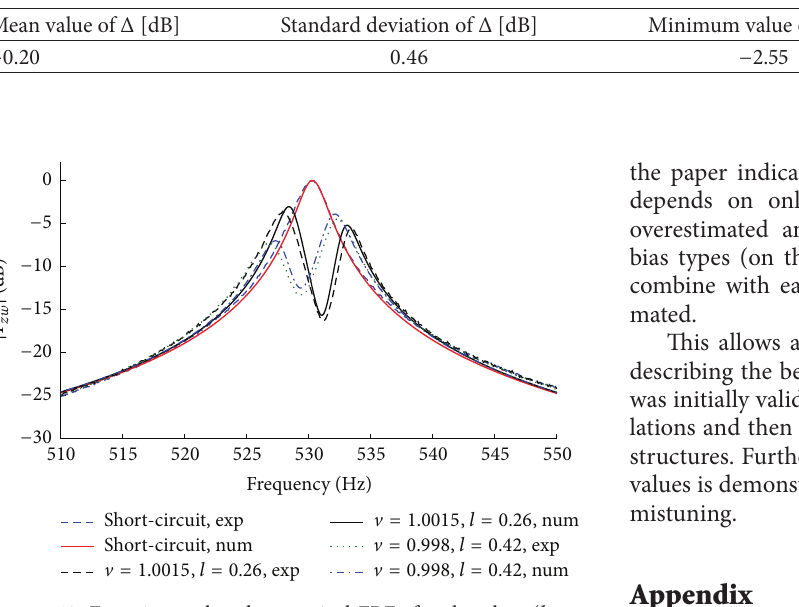
Figure 12: Experimental and numerical FRFs for the plate ( 𝑘 𝑛 =